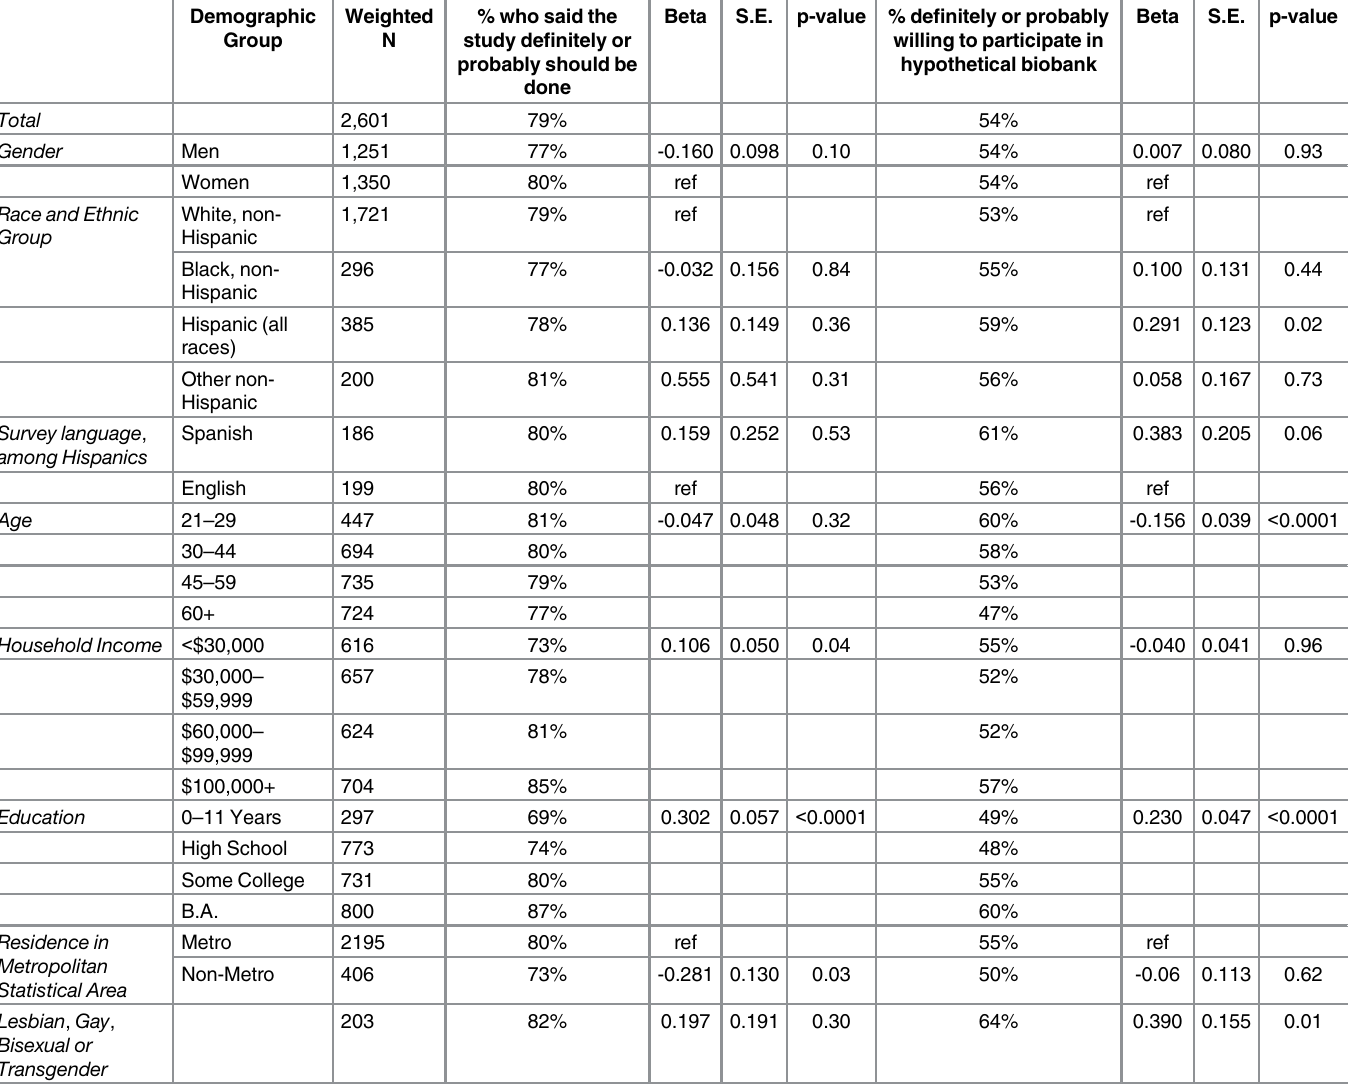
Table 2. Results of two multiple logistic regressions examining demographic factors related to survey respondents ’ support for the national cohort study, and their willingness to participate in the study if asked (n = 2,601). Each multiple logistic regression included independent covariates for gender, self-identified race and ethnic group, survey language (among Hispanics only), age, household income, educational attainment, residence within or outside a metropolitan statistical area, and identification as either lesbian, gay, bisexual or transgender. For purposes of the analysis, race and ethnicity was treated as a categorical variable, using dummy variables for black non-Hispanics, Hispanics, and other non-white, non-Hispanics. Education, household income, and age were each treated as 4-level variables using the categories shown below. To examine whether there were differences among Hispanics who took the survey in Spanish and English, separate regressions were conducted using Hispanic respondents ’ data only, adjusting for all of the variables below except for race and ethnic